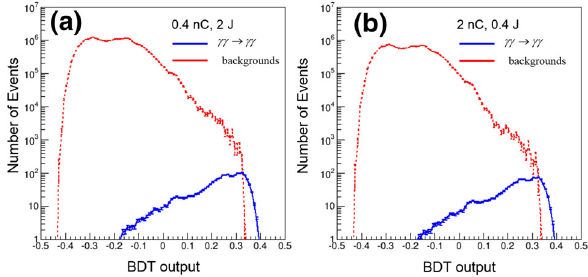
Fig. 8 Expected BDT distribution for γγ → γγ (blue-solid) and sum of all background events (red-dashed) with 1-year operation for the operating conditions of (0.4 nC, 2 J) ( a ), and (2 nC, 2 J) ( b ). The errors on data points are calculated with the statistics of MC events